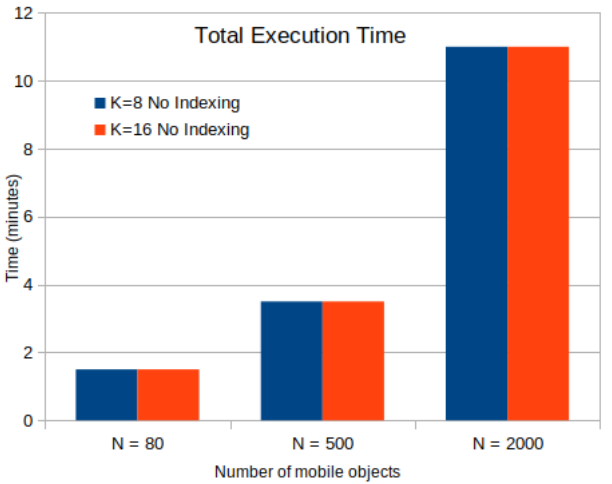
Figure 5. Time Cost for k -Anonymity Set Computation with or without Indexing for N = 80,500,2000 Mobile